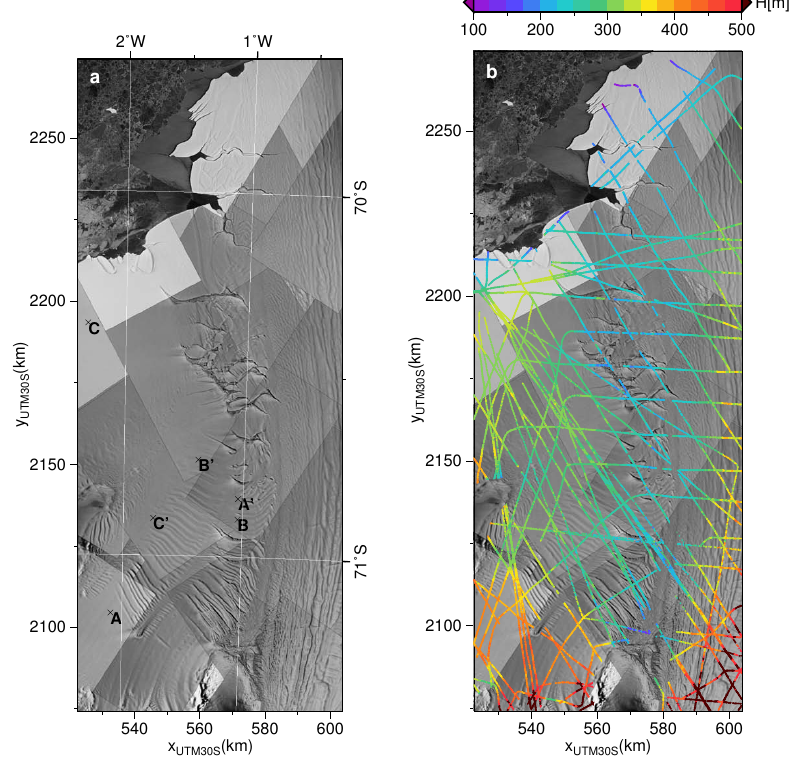
Fig. 2. Panel (a) : subset of the TerraSAR-X mosaic showing the western rift area of Fimbulisen, as well as large parts of the extension of Jutulstraumen. Panel (b) : same as left, with superimposed ice thickness along RES profiles in colour. the RES system see Nixdorf et al. (1999). The